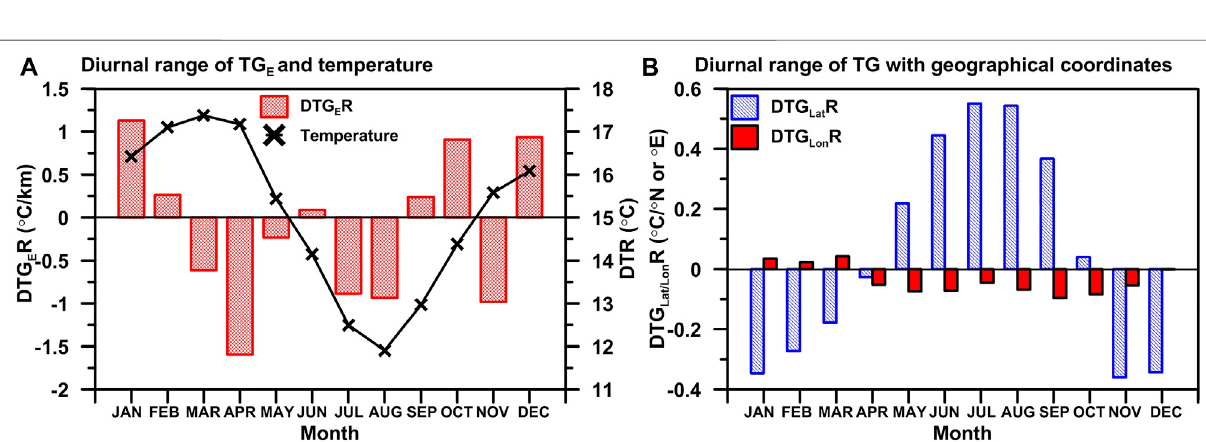
Frontiers in Earth Science |